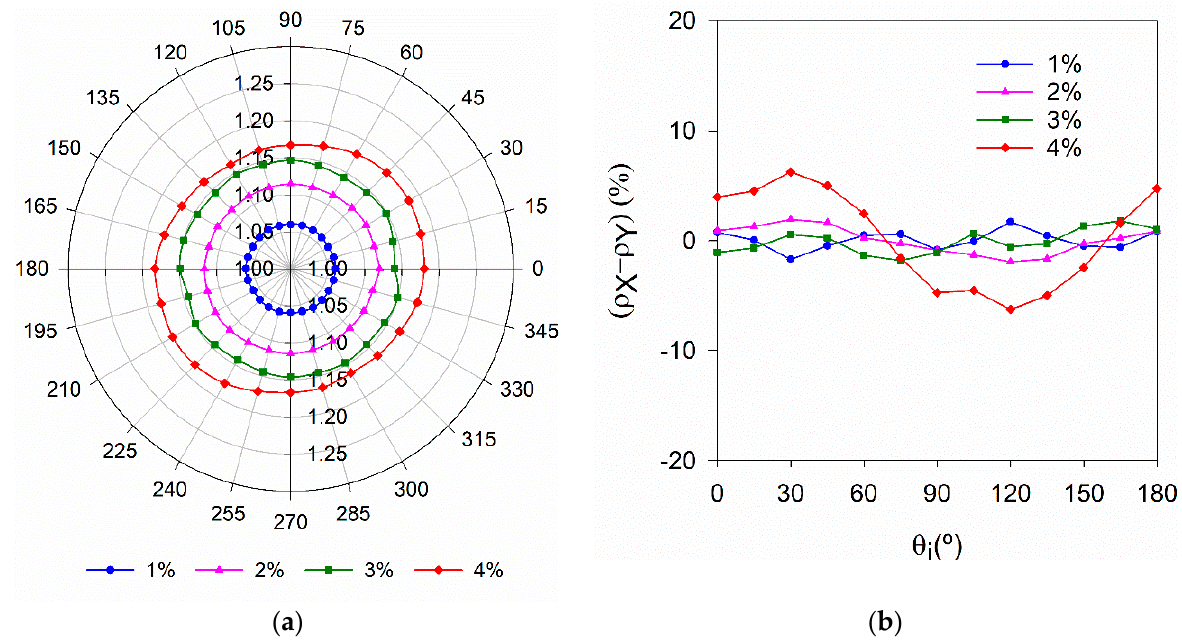
Figure 10. Variation of ( a ) µ r and ( b ) ( ρ X − ρ Y ) with the measuring direction (specimens with h U = 100